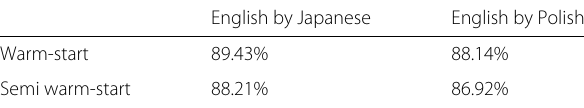
Table 3 Results of conducted experiments for setup 2